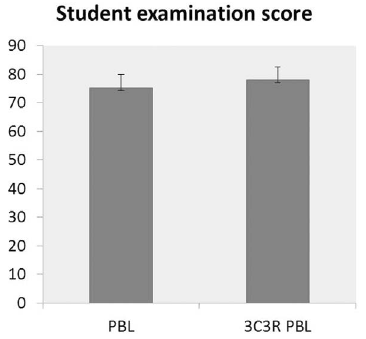
Figure 4. Comparison of overall test scores from students for 3C3R-PBL and PBL.